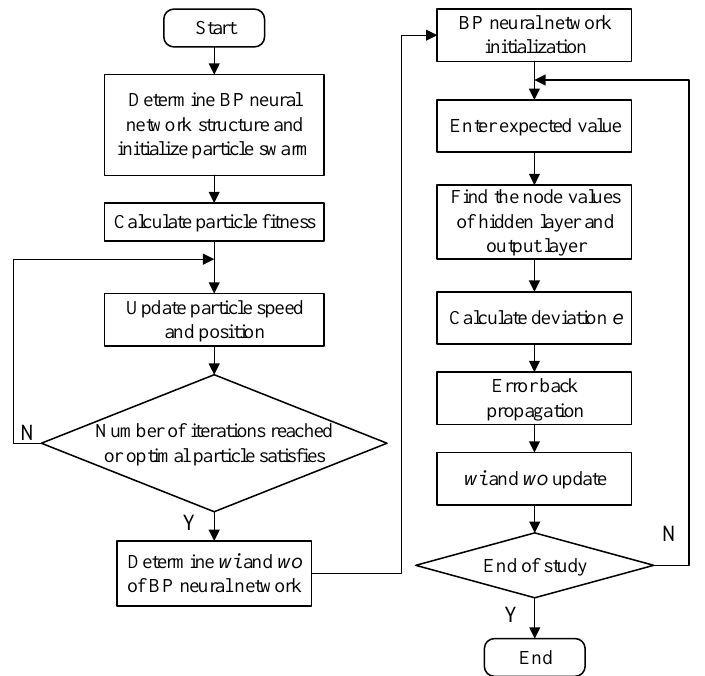
Figure 7. Flow chart of the BP neural network optimization based on particle swarm optimization